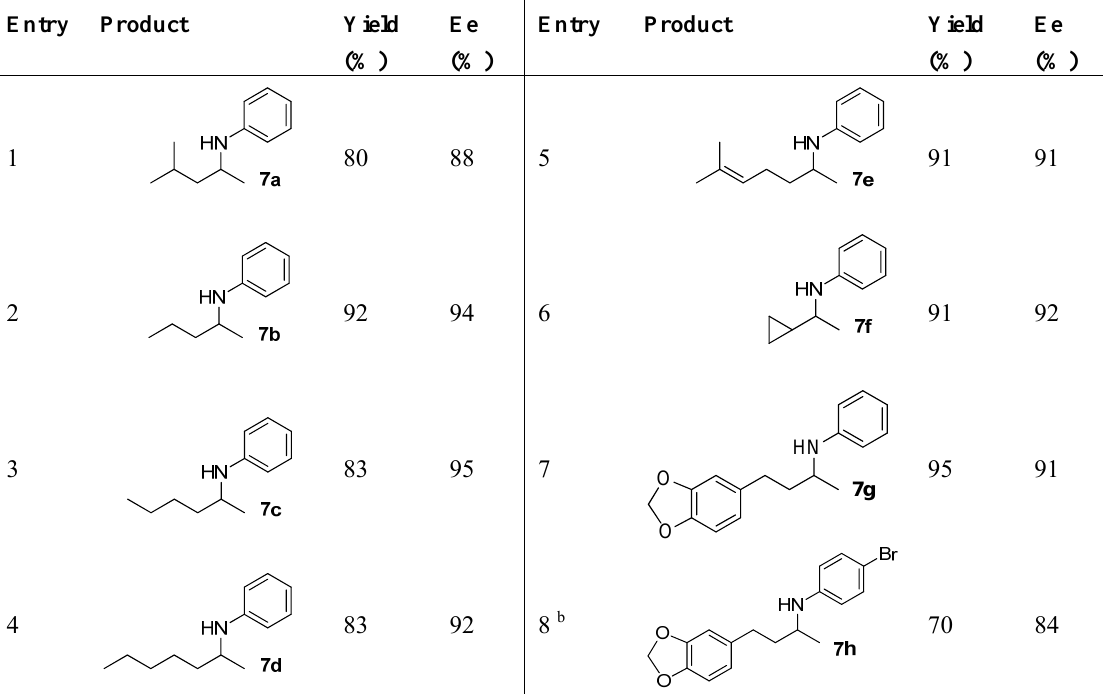
Table 4. DARA with aniline and 4-bromoaniline. a